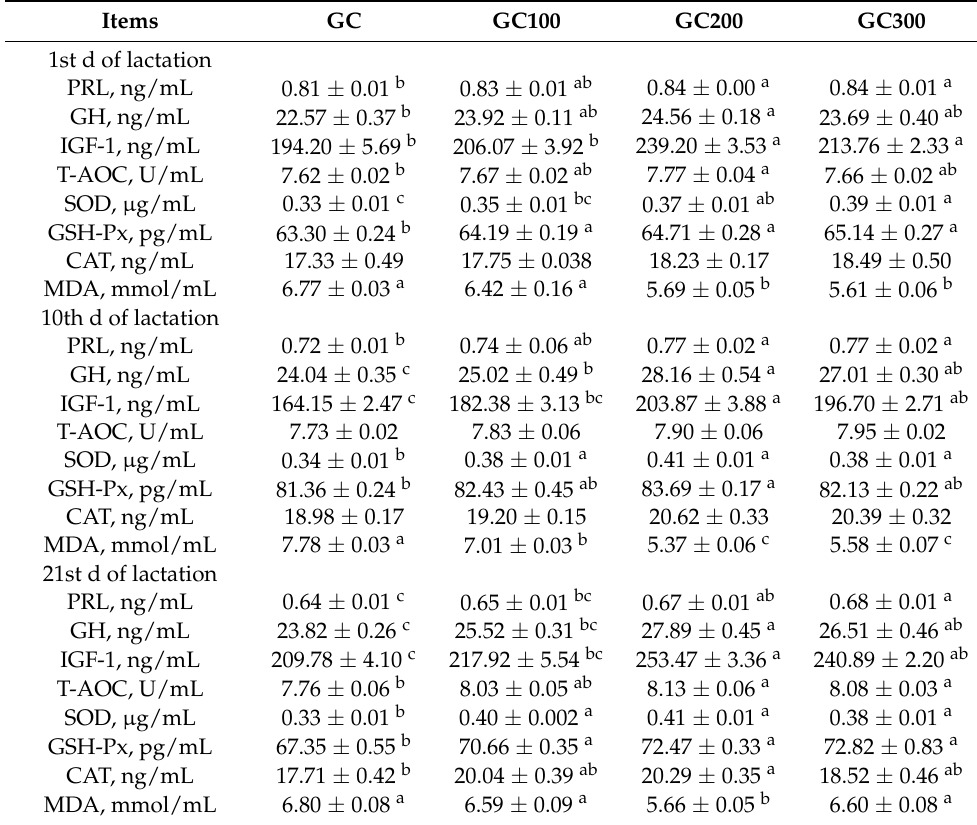
Table 6. Effects of SI and APS mixture on serum hormone level of lactating sows.